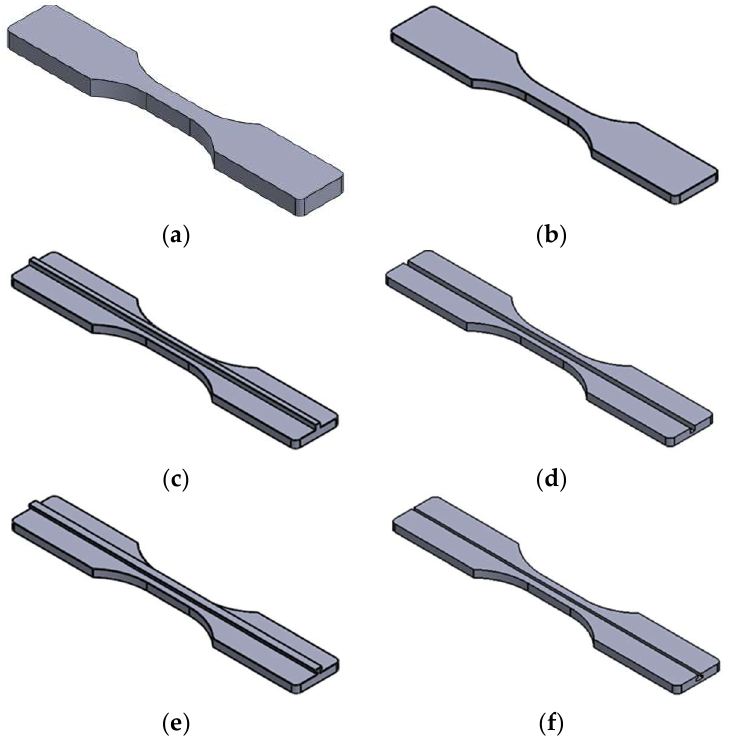
Figure 2. CAD models of all FDM articles.